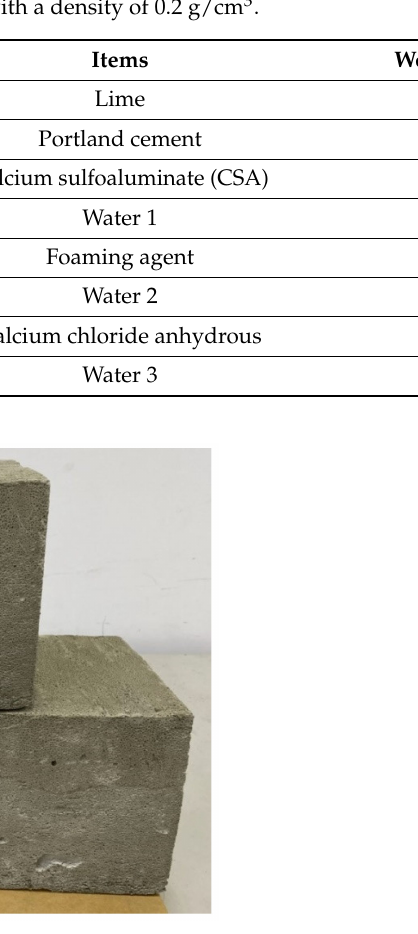
Figure 20. Three slab samples with a density of 0.2 g/cm 3